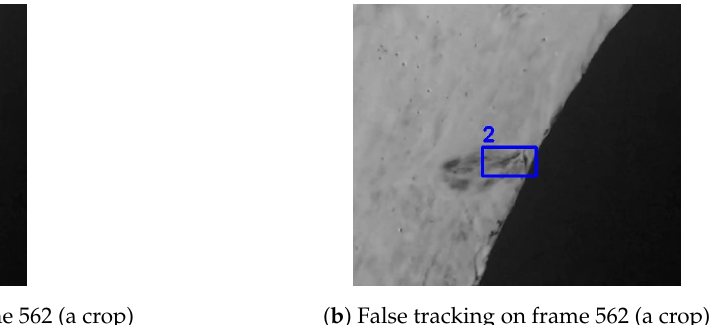
Figure 10. False detection and the corresponding